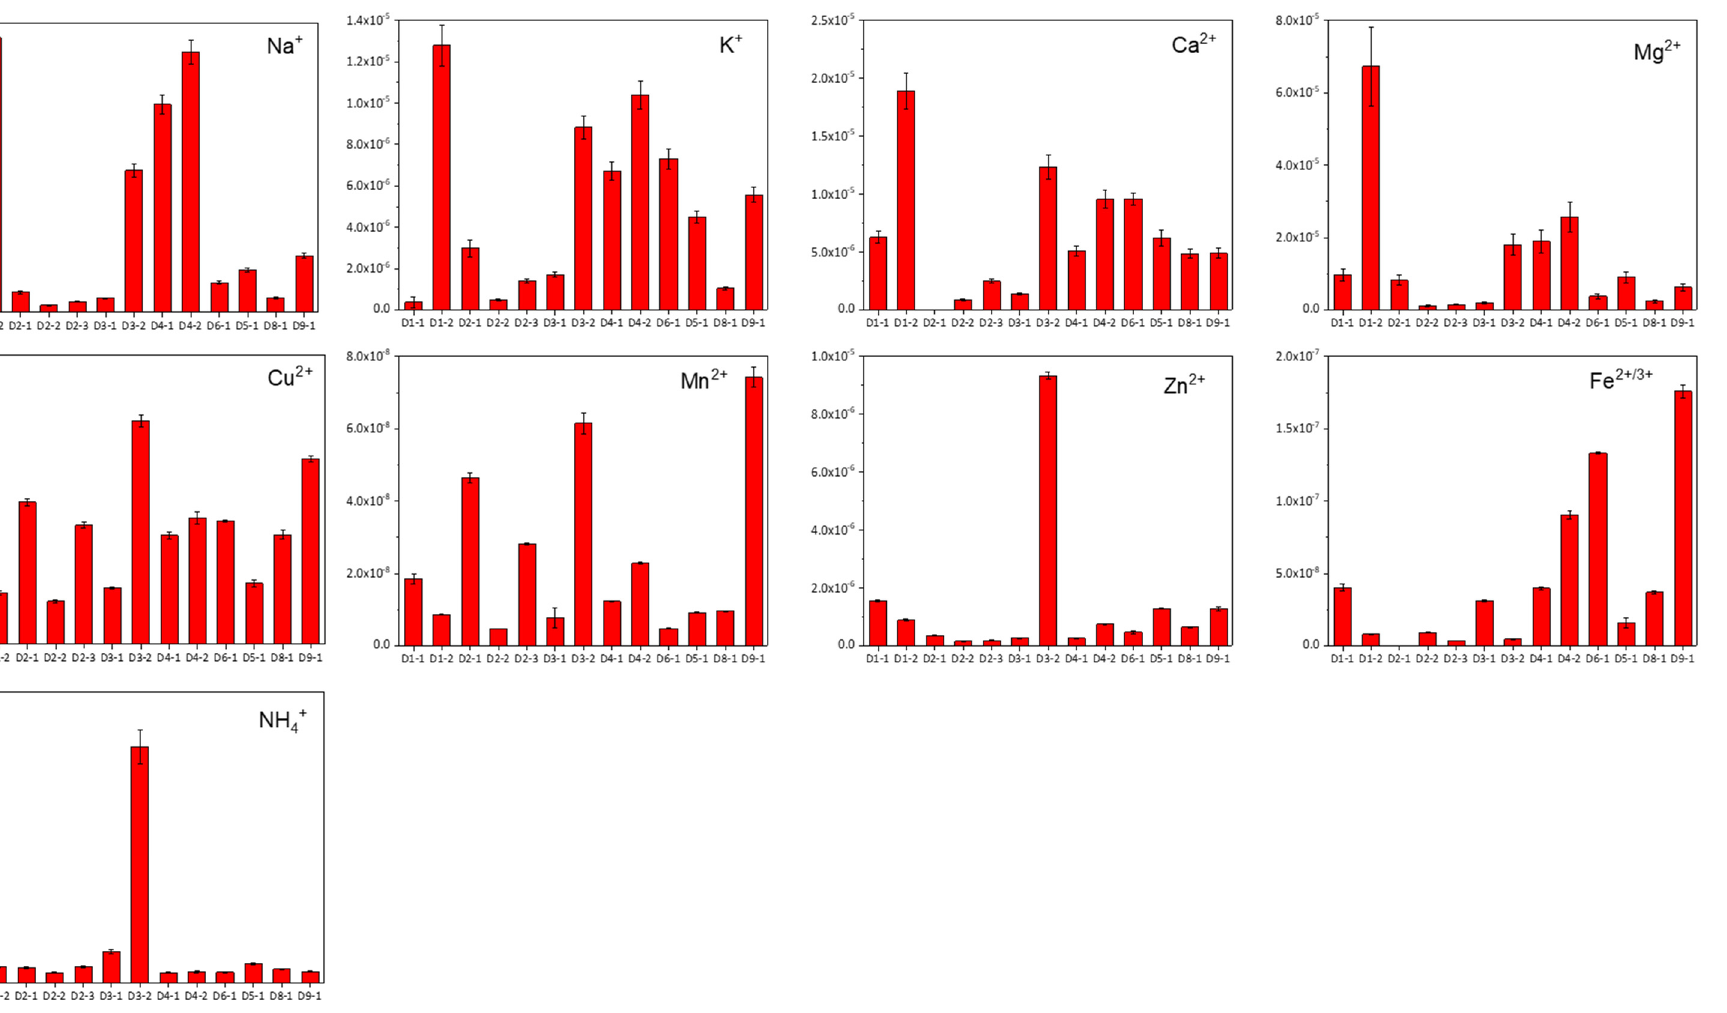
Figure 2. Concentrations and corresponding standard deviations (mol L − 1 ) of the cations of the atmospheric deposition samples. The horizontal axis labels represent the sample codes (see Table 1).